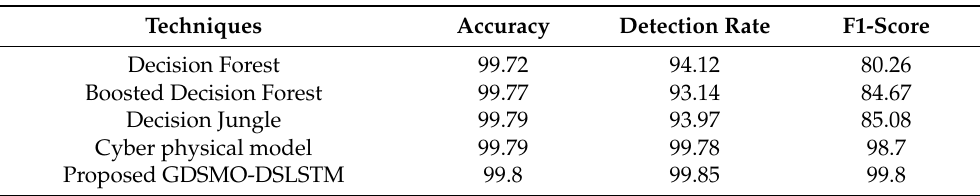
Table 5. Accuracy, detection rate, and F1-score of existing and proposed classification techniques using the SCADA network dataset.